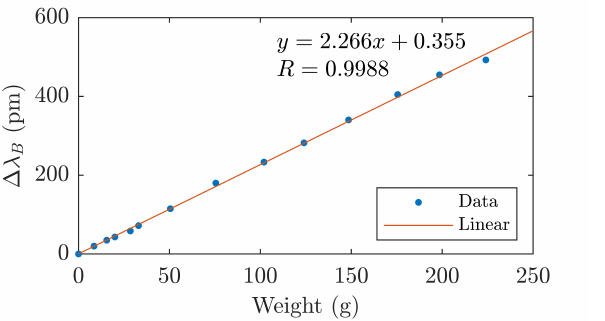
Figure 6. Pressure sensor calibration curve, Bragg wavelength dependence on membrane